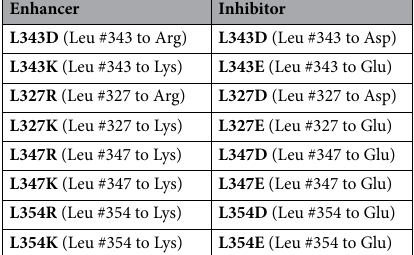
Table 7. Leucine (Leu/L) amino acid